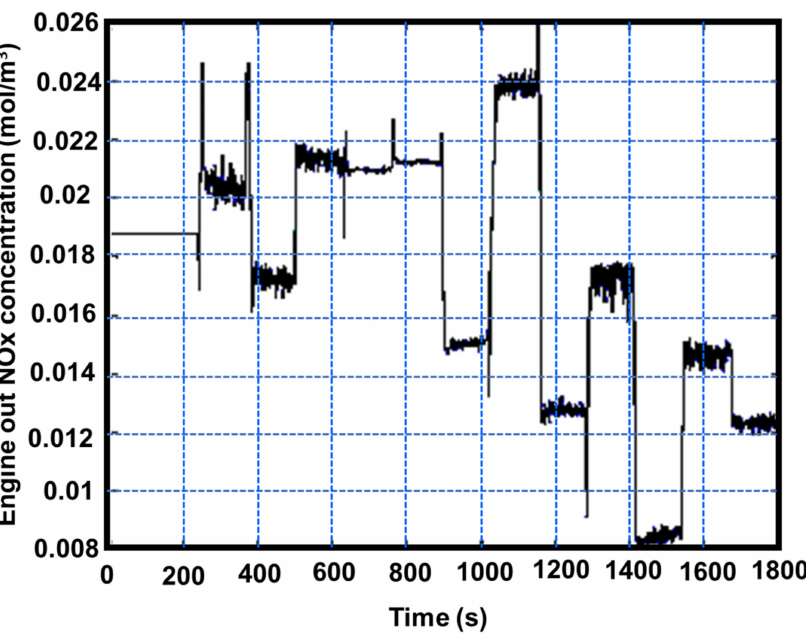
Figure 21. Engine-out NOx concentration over the ESC test, adapted from Wei et al. [45,67].